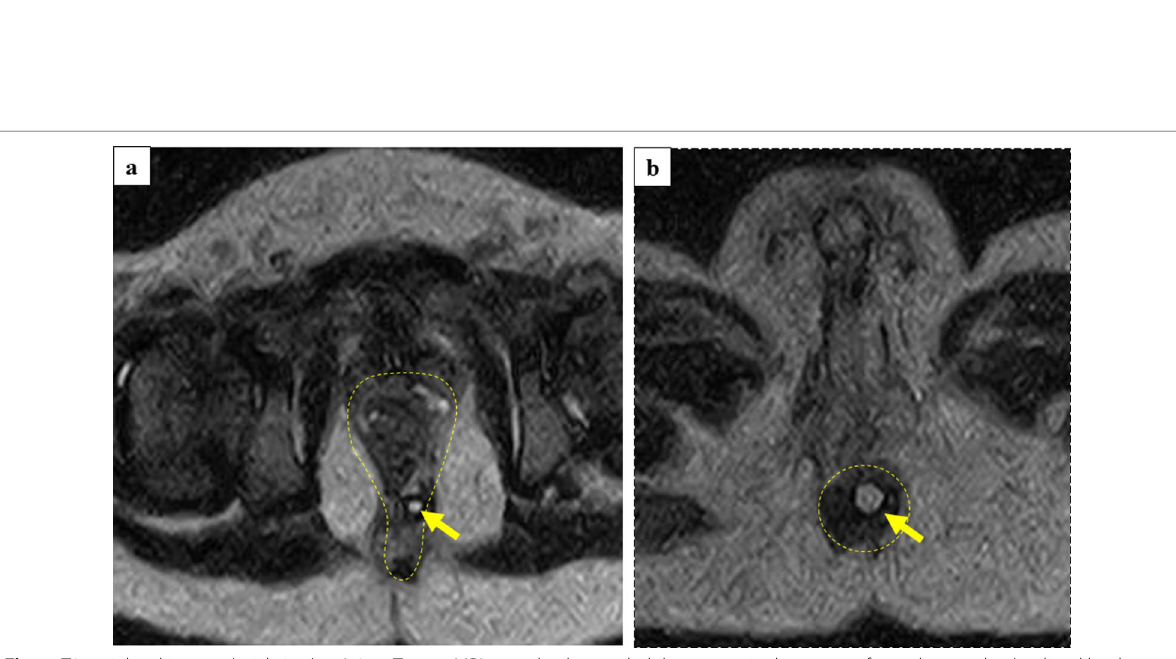
Fig. 5 T2-weighted images (axial view). a A 0.45-T open MRI scan clearly revealed the rectum in the center of muscle complex (outlined by dot line). To clarify rectal pull-through, a 1 ml syringe filled with physiological saline was inserted in the anus (arrow). b Dot line showed the external sphincter muscle. Pull through rectum (1 ml syringe filled with physiological saline: arrow) was confirmed at the center of the external sphincter